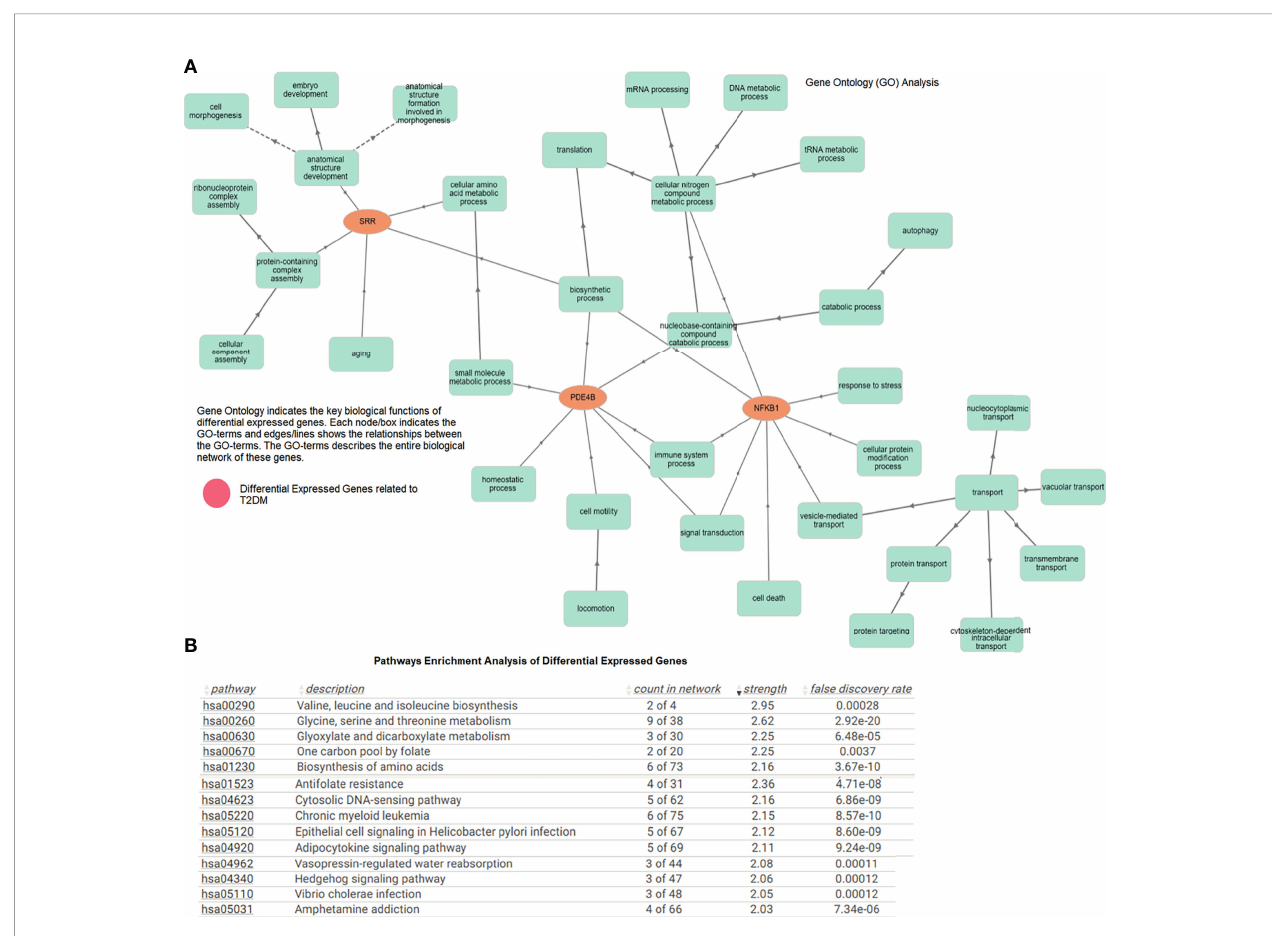
FIGURE 3 | (A) Gene Ontology network of the differentially expressed genes indicating important biological functions. (B) Pathway enrichment analysis showing the enriched terms associated with type 2 diabetes mellitus